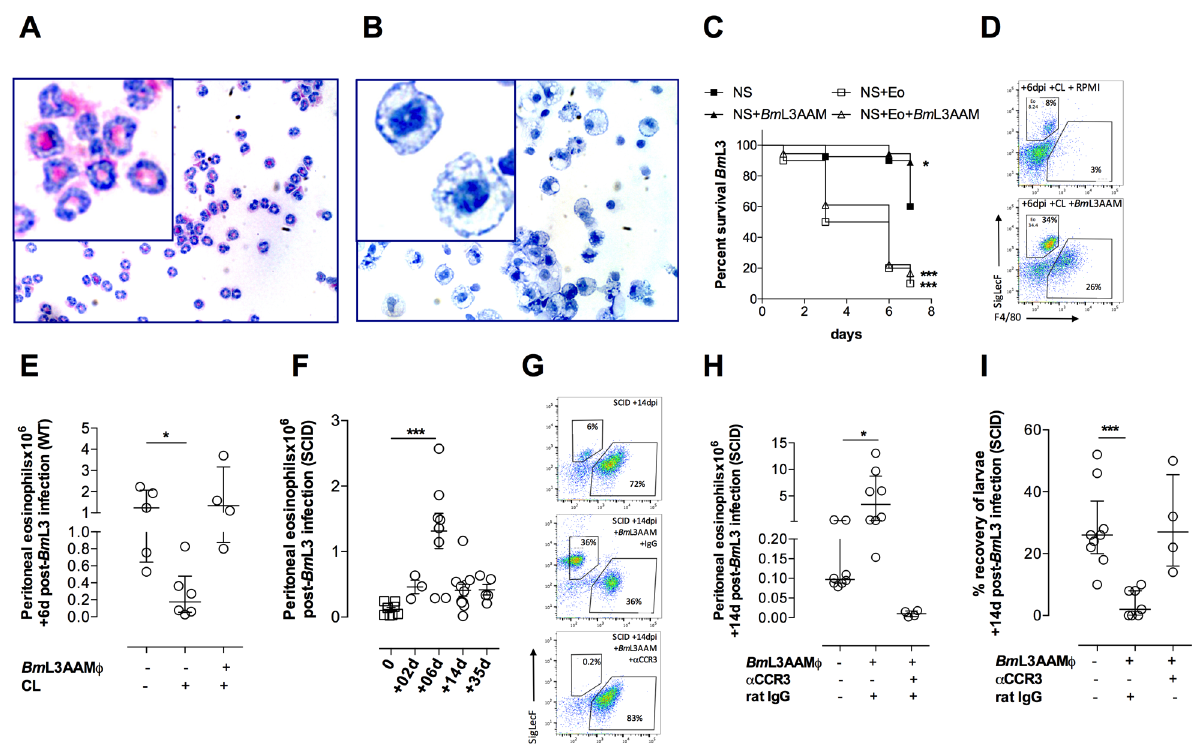
Fig 6. Bm L3AAM ϕ are necessary to sustain a larvicidal tissue eosinophilia. Cytospins of FACS-sorted BALB/c WT peritoneal SigLecF + eosinophils (A) or Bm L3AAM ϕ (B) +14 days post-infection with 50 Bm L3. Survival analysis of Bm L3 (C) throughout 7-days culture with normal mouse serum (NS) or co-cultured with 10 6 FACS-sorted eosinophils (Eo), 10 6 Bm L3AAM ϕ or combinations of Eo+ Bm L3AAM ϕ , (cells sourced as for A,B). Data is pooled from two individual experiments evaluating motility of 10 Bm L3 per condition. Significance of Kaplein-Meir survival analysis vs NS serum control is indicated per condition. Eosinophilia (D,E) +6dpi with 50 Bm L3 ip in BALB/c WT mice pre-treated with clodronate liposomes (CL) ip +/- adoptive transfer of 0.75x10 6 Bm L3AAM ϕ ip (cells sourced as for B). Time course of peritoneal eosinophilia in BALB/c SCID mice at indicated time points post infection with 50 Bm L3 ip (F) . Peritoneal eosinophilia (G,H) or recovery of B . malayi larvae (I) at +14 days post- infection with 50 Bm L3 in BALB/c SCID and E) and pre-treatment with either rat IgG or rat α CCR3 antibody. Data from individual mice with median and interquartile range are plotted. Significant differences between groups assessed by Kruskal-Wallis + Dunn’s tests. Data is from an individual experiment or pooled from 2–3 individual experiments per time-point using groups of 4–6 mice per group / time-point.